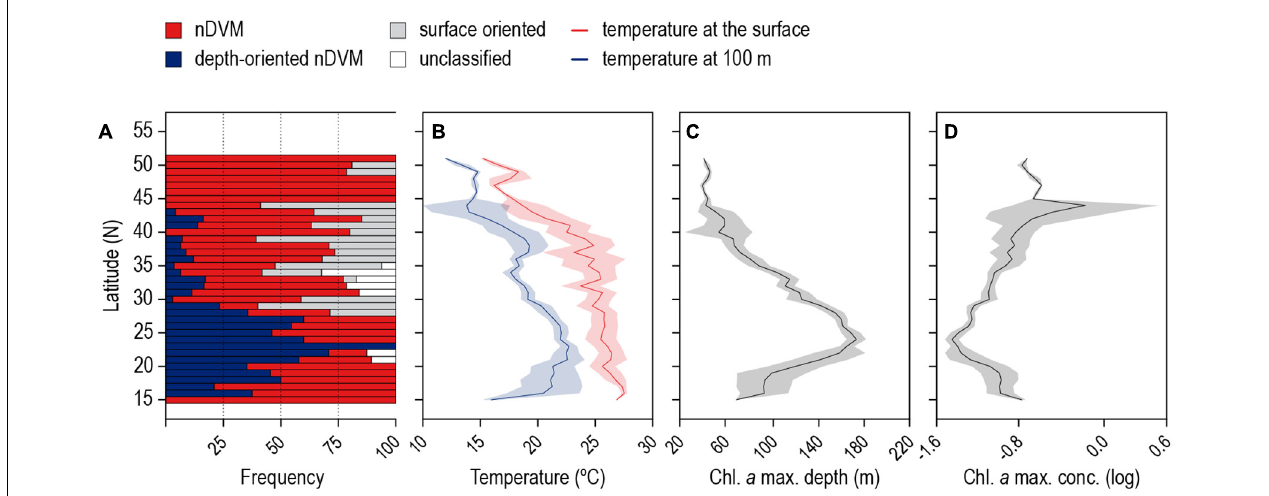
FIGURE 8 | Latitudinal variation between 15 and 51 ◦ N for the (A) frequency of classified diel behaviours, (B) average temperature at the surface (red) and at 100 m depth (blue), (C) depth and (D) concentration of the chlorophyll a maximum in the water